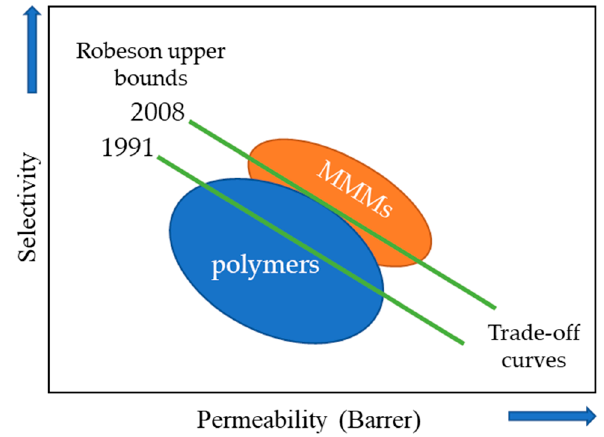
Figure 1. Diagram of the trade-off between selectivity and permeability.